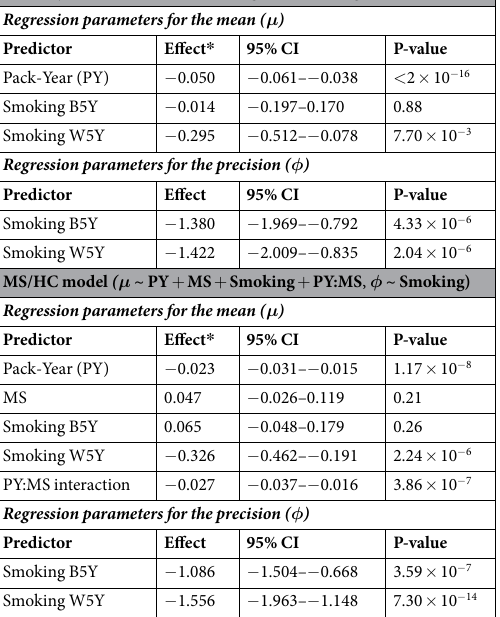
Table 2. Summary of the beta regression. * Effect: indicates the change in log-odds for the DNA methylation estimate (logit